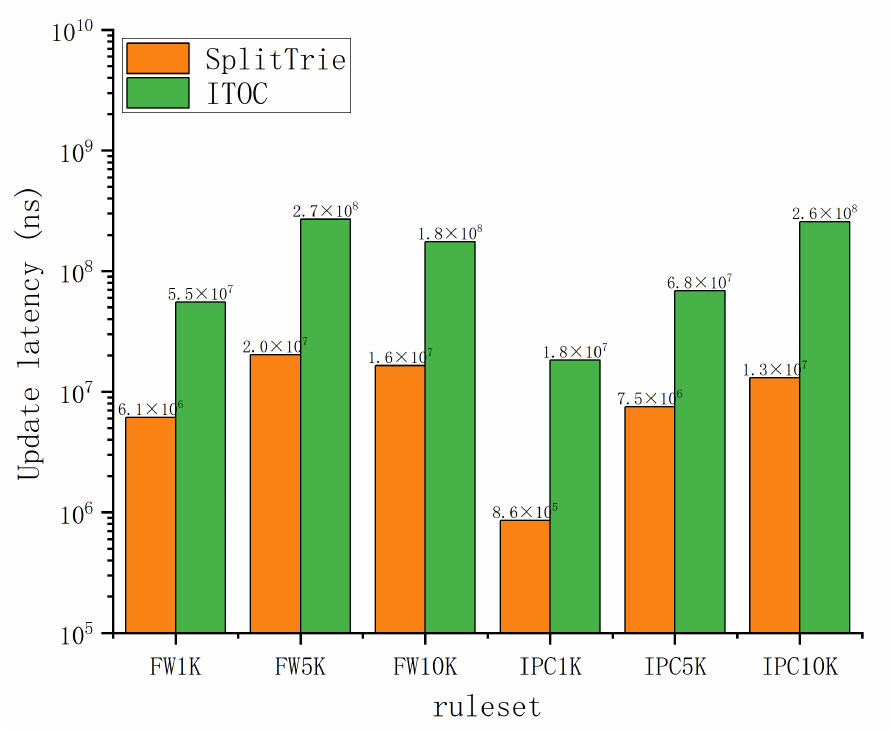
Figure 9. The update latency comparison between SplitTrie and